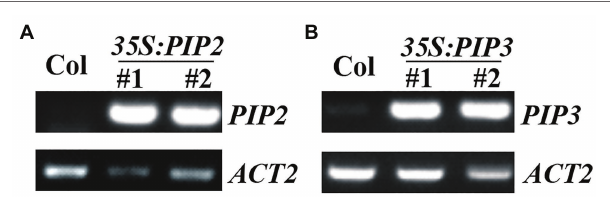
FIGURE 2 | Expression of PIP2 and PIP3 in the 35S:PIP2 and 35S:PIP3 transgenic plants. (A) Expression of PIP2 in the 35S:PIP2 transgenic plants. (B) Expression of PIP3 in the 35S:PIP3 transgenic plants. Total RNA was isolated from 10-day-old homozygous transgenic plants and RT-PCR was used to examine the expression of PIP2 or PIP3 . Expression of ACT2 was used as a